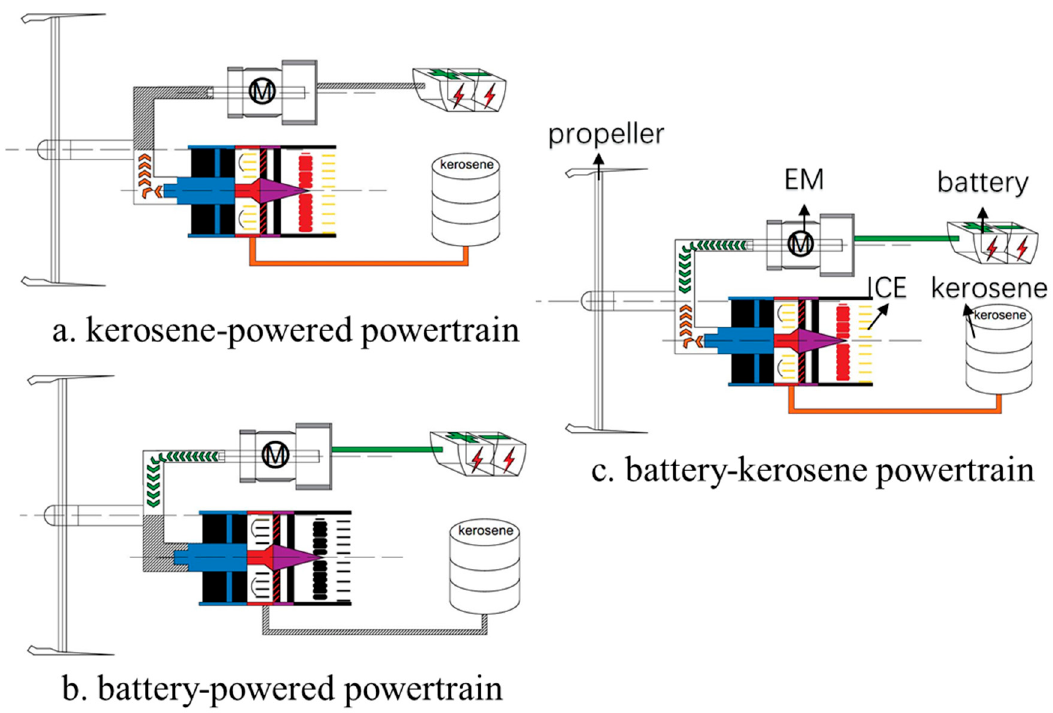
Figure 4. Independently parallel hybrid propulsion architecture: ( a ) kerosene-powered powertrain, ( b ) battery-powered powertrain, ( c ) battery-kerosene powertrain.